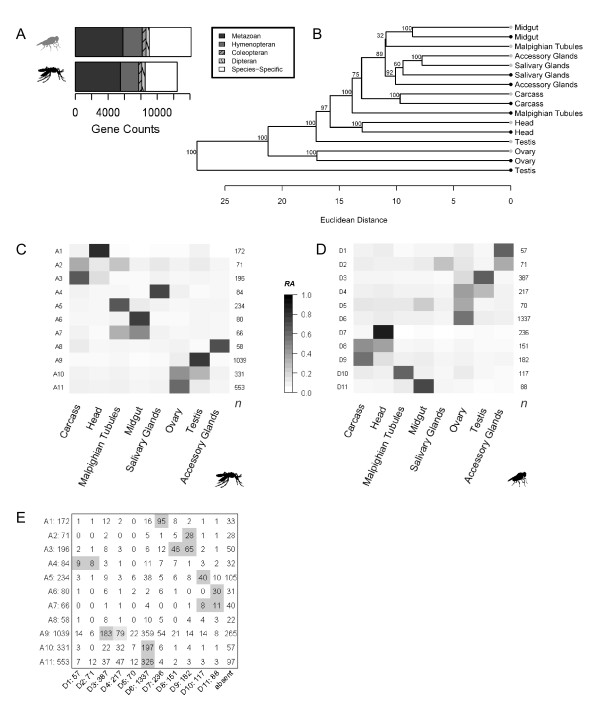
Orthology Relationships. (A) The oldest common ancestor in gene-families to either a Dipteran, Coleopteran, Hymenopteran or Metazoan ancestor. (B) Expression divergence of tissues for one-to-one orthology pairs (n = 4234). Euclidean distance was used to calculate similarity among tissues within and between species. Branch support was estimated with 10,000 bootstrapped replicates. Drosophila (grey); Anopheles (black). (C) Mean expression of Anopheles orthologue clusters and (D) mean expression of Drosophila orthologues clusters. Mean relative expression (RA) level for each cluster according to grayscale. (E) The number of overlapping orthologous genes between Anopheles and Drosophila expression clusters calculated with a hypergeometric probability distribution after multiple correction. Light grey (P < 0.05); Dark grey (P < 0.01).